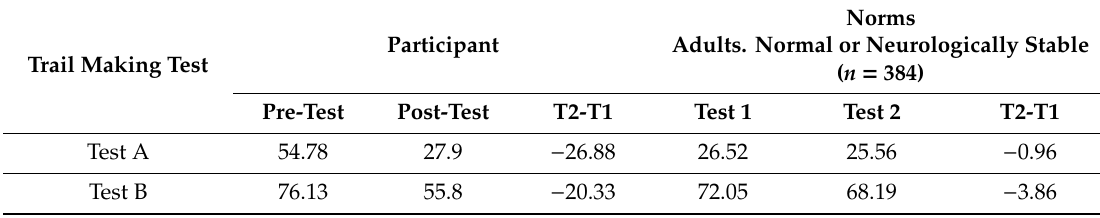
Table 1. Results of Trail Making Test A and B and Comparison to Normative Data